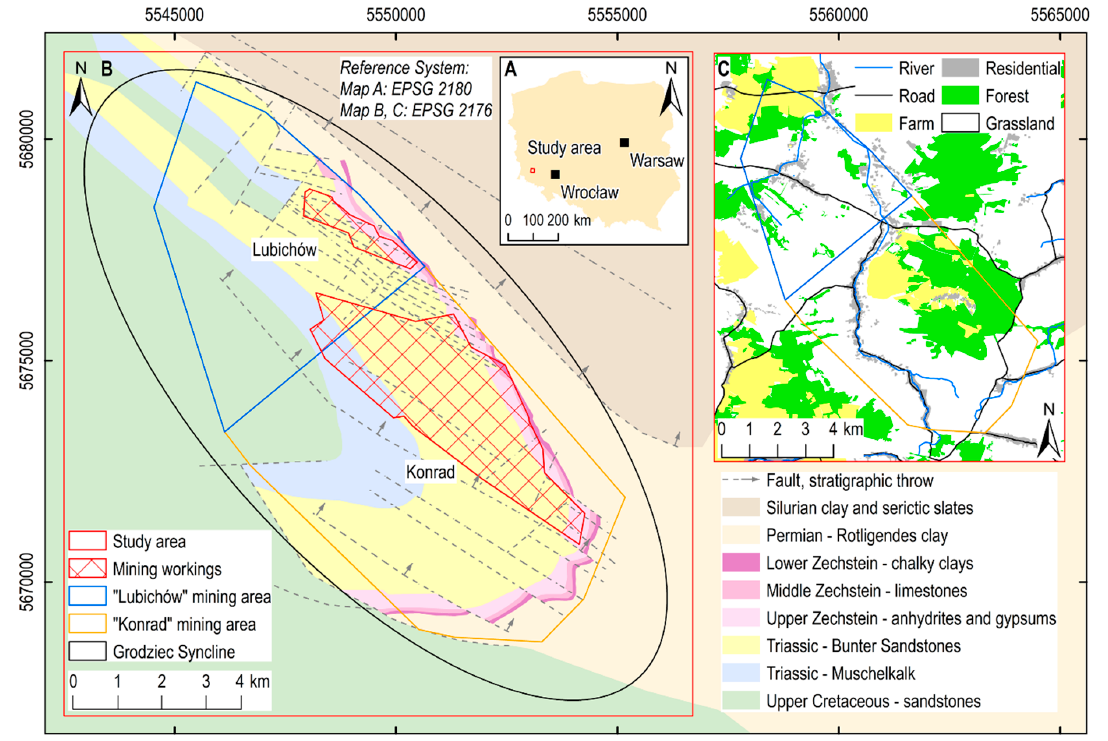
Figure 1. The location of the study area on a map of Poland ( A ), geological and tectonic settings ( B ), and land use ( C ), modified after and land use ( C ), modified after [32].